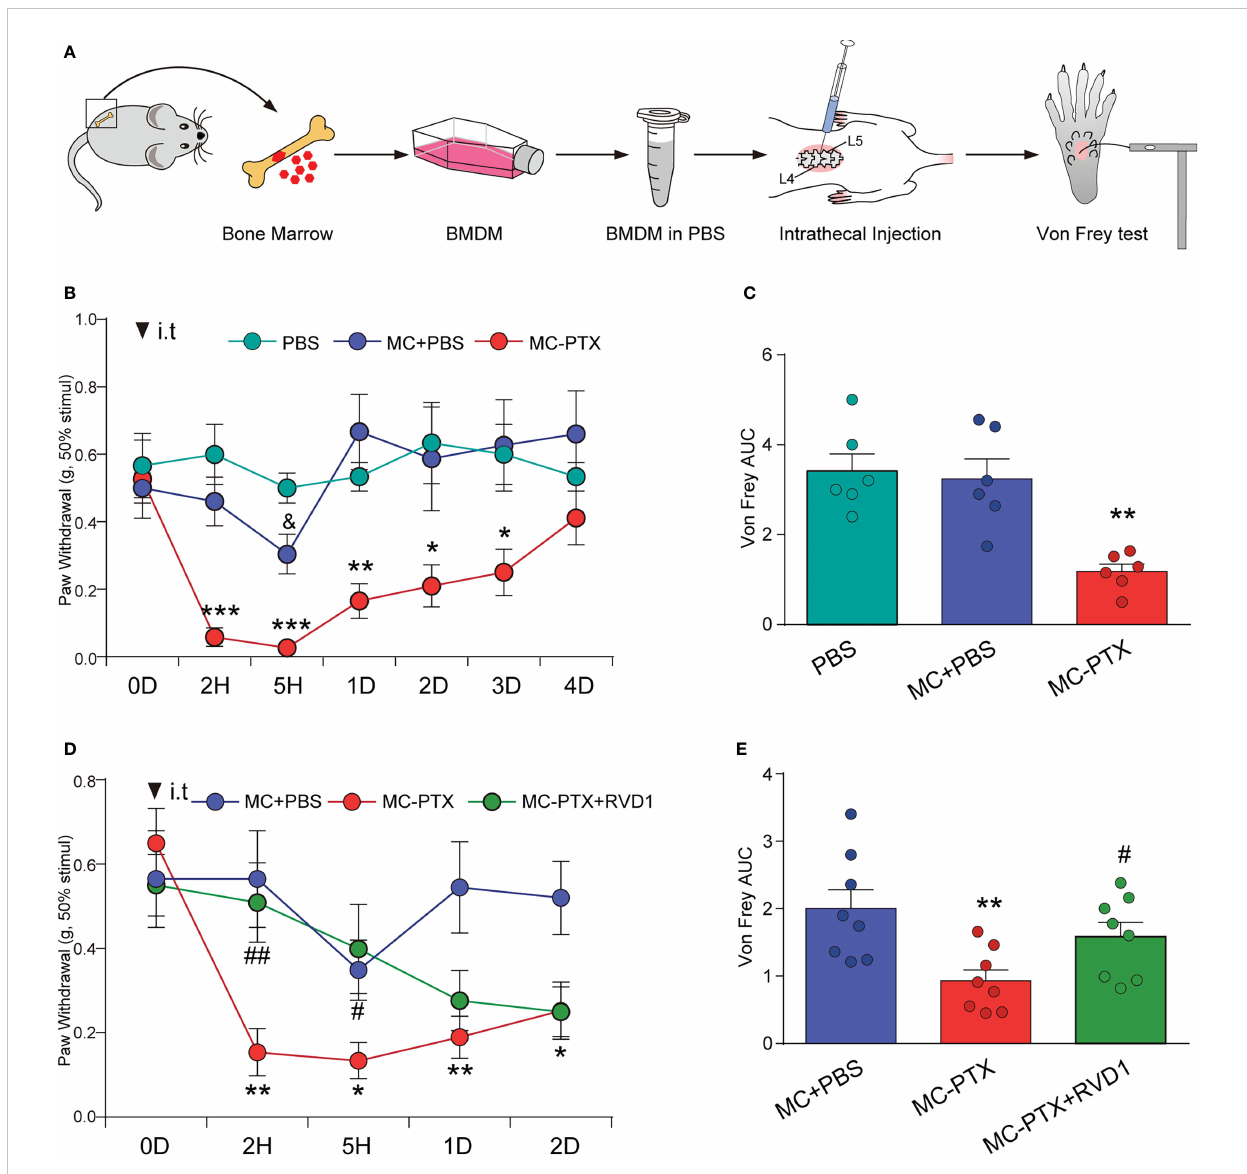
FIGURE 3 RvD1 attenuates mechanical allodynia induced by PTX via regulating macrophages. Mouse bone marrow-derived macrophages (BMDMs) were pretreated with 250 nm RVD1 for 3h, and then treated with 1 m M PTX for 24h. BMDMs of different treatment groups (3×10 3 ) were intrathecally injected into mice intervertebral foramen. The process is shown schematically in (A) . Mechanical pain threshold was determined using Von Frey test (B, D) , AUC analysis was shown in (C, E) . *p < 0.05, **p < 0.01, ***p < 0.001 vs normal MC group; #p < 0.05, ##p < 0.01 vs MC-PTX group. n=6 in each group (B, C) ; n=8 in each group (D, E) . MC, macrophage; RvD1, resolvin D1; PTX,